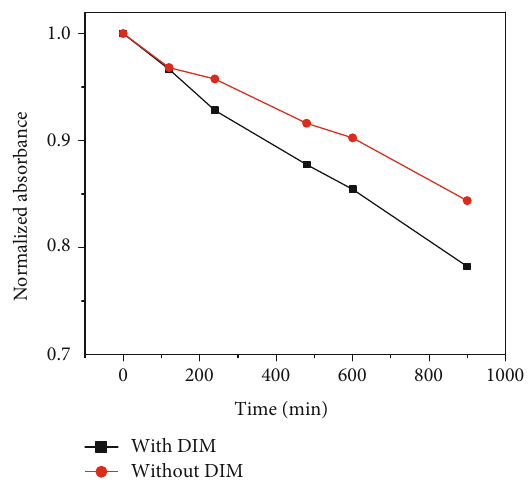
Figure 2: Normalized UV-visible absorbance of PCDTBT:PC processed with and without DIM as a function of irradiation (100mW/cm 2 light) time at ambient air.